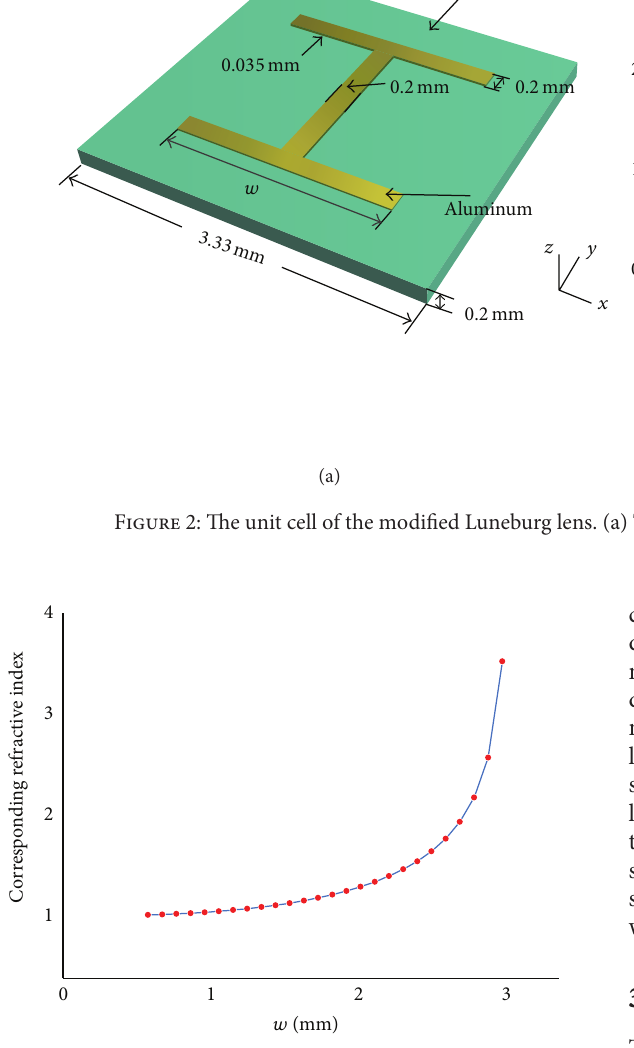
Figure 3: The relationship between the parameter 𝑤 (shown in Figure 2(a)) and the corresponding effective refractive